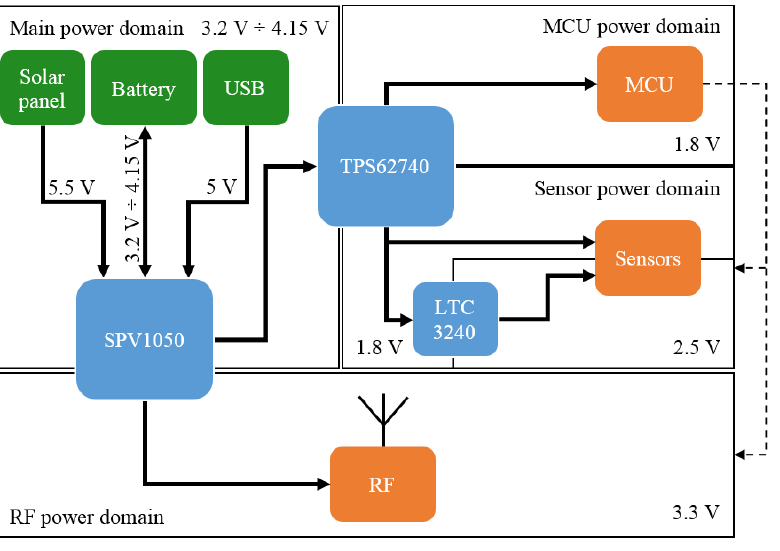
Figure 10. Power management graph in the